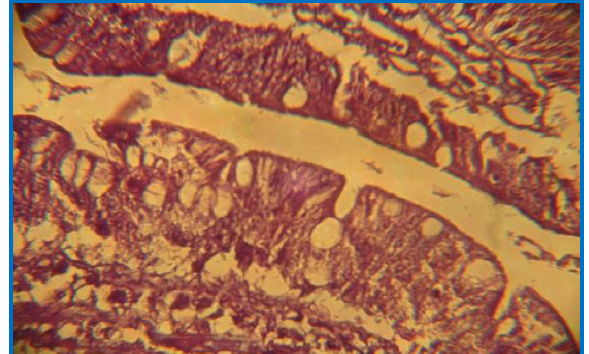
Figure10: Intestine of 4th group (control negative) revealed no clear lesion. (H and E stain,